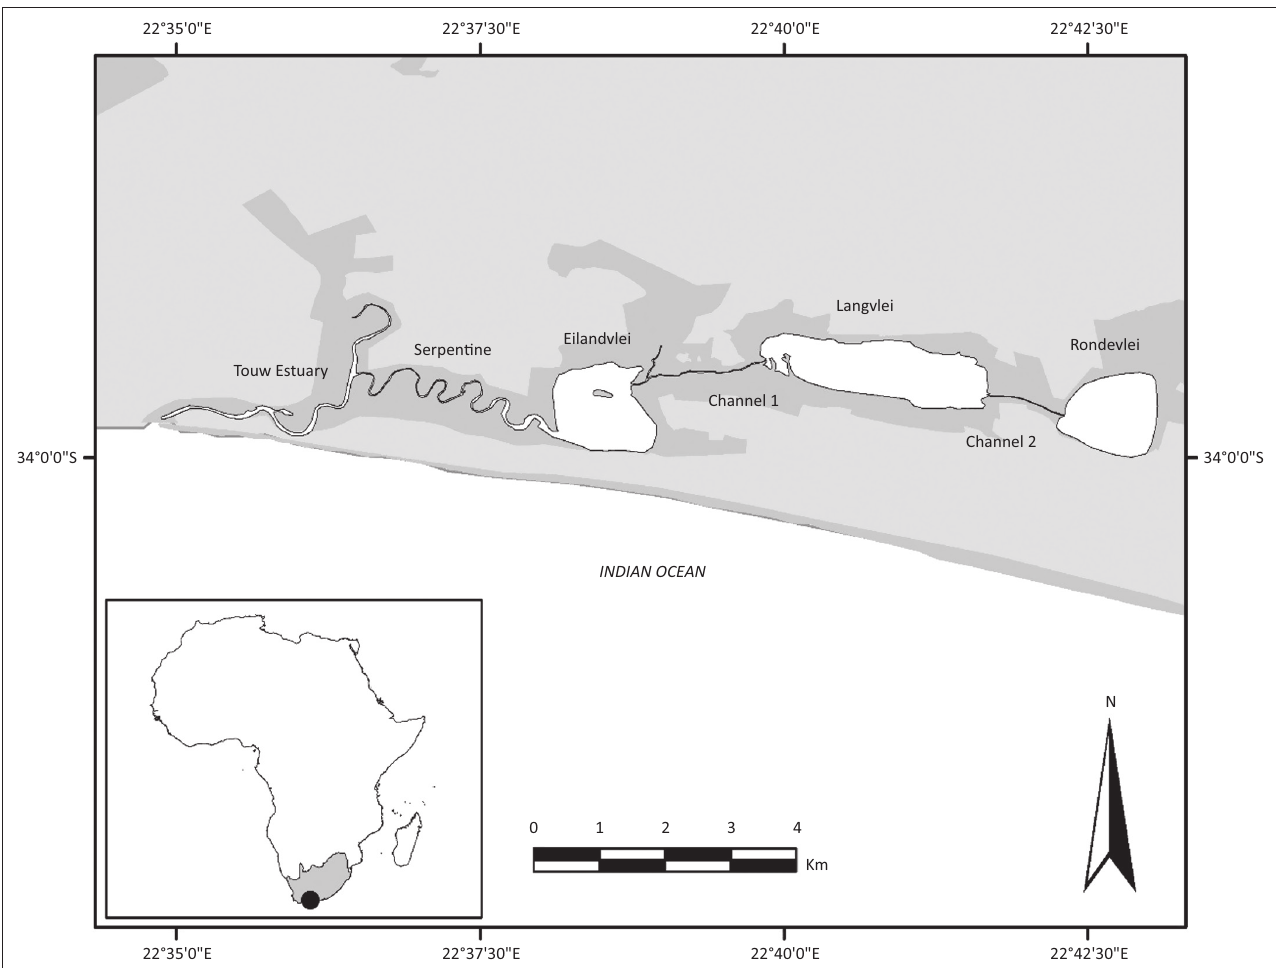
FIGURE 1: Map of the Wilderness Lakes